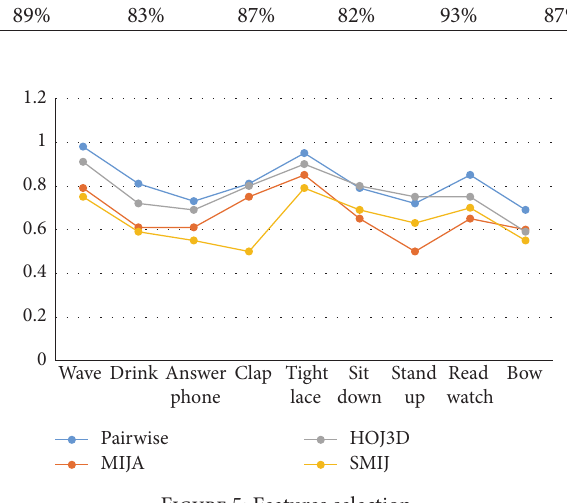
Figure 5: Features selection.